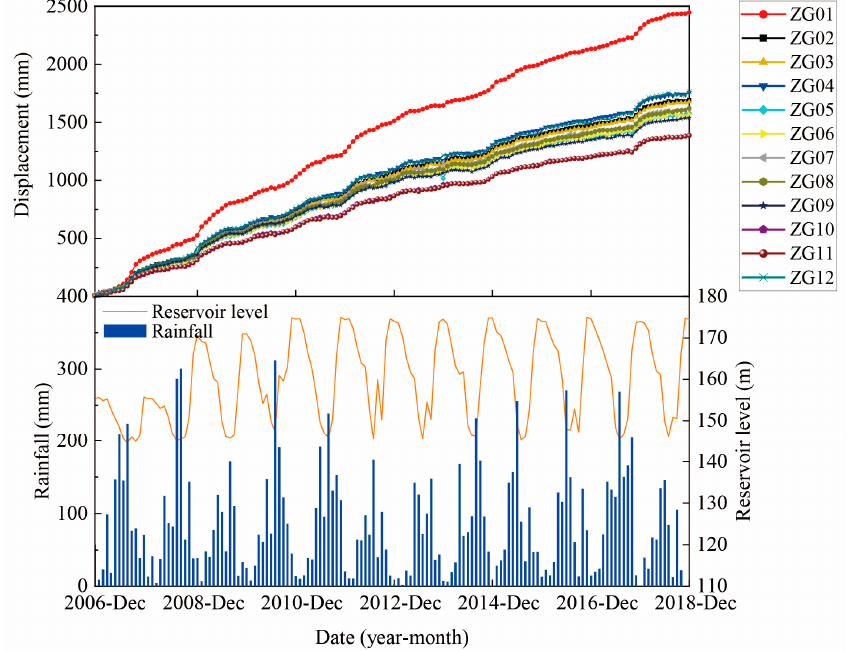
Figure 5. The monitoring data of cumulative displacement, the reservoir water level, and rainfall in the Muyubao landslide.